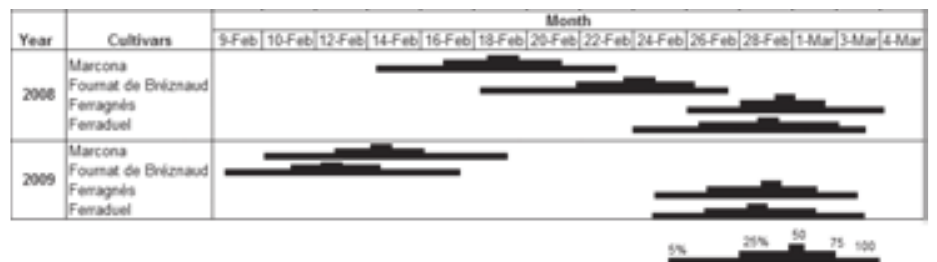
Figure 1. Season of flowering in 2008 and 2009. Percentages indicate the amount of open flowers